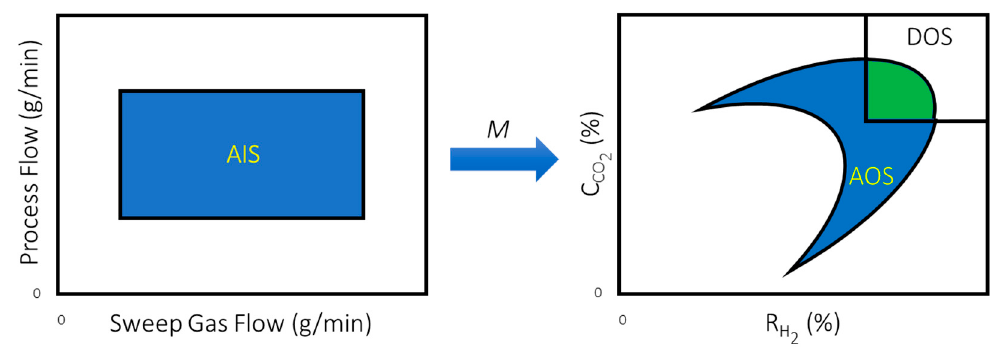
Figure 4. Schematic of the process operability concept. The fraction of the DOS covered by the green region would correspond to the operability index (OI) for the design.